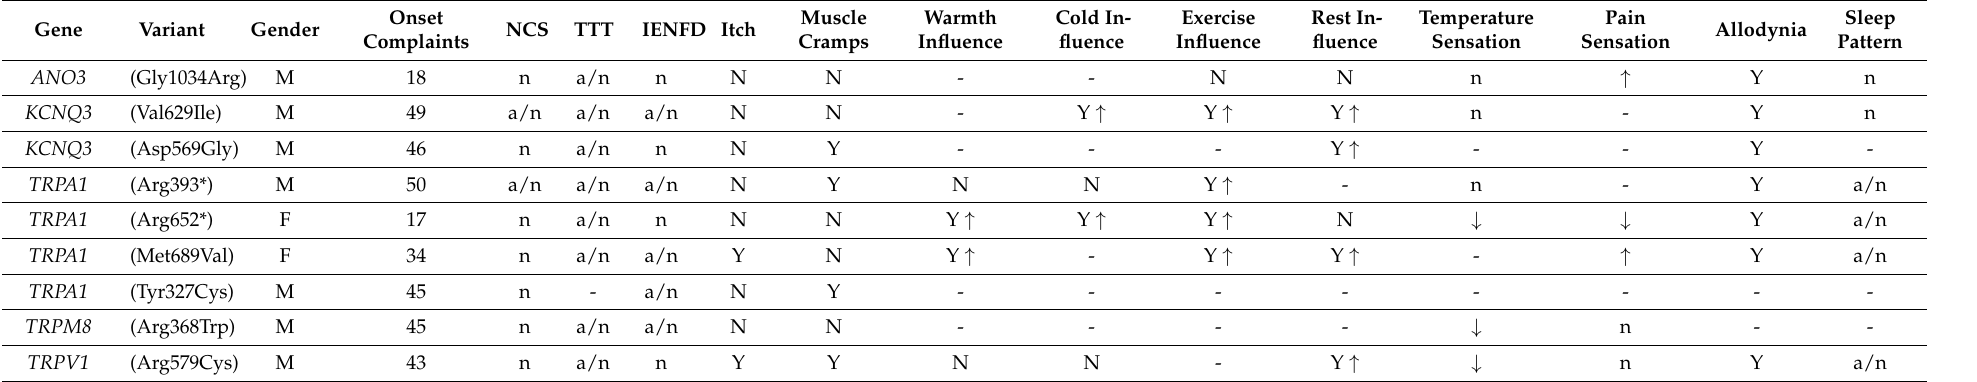
Table 4. Clinical features of SFN patients carrying an ICG variant.